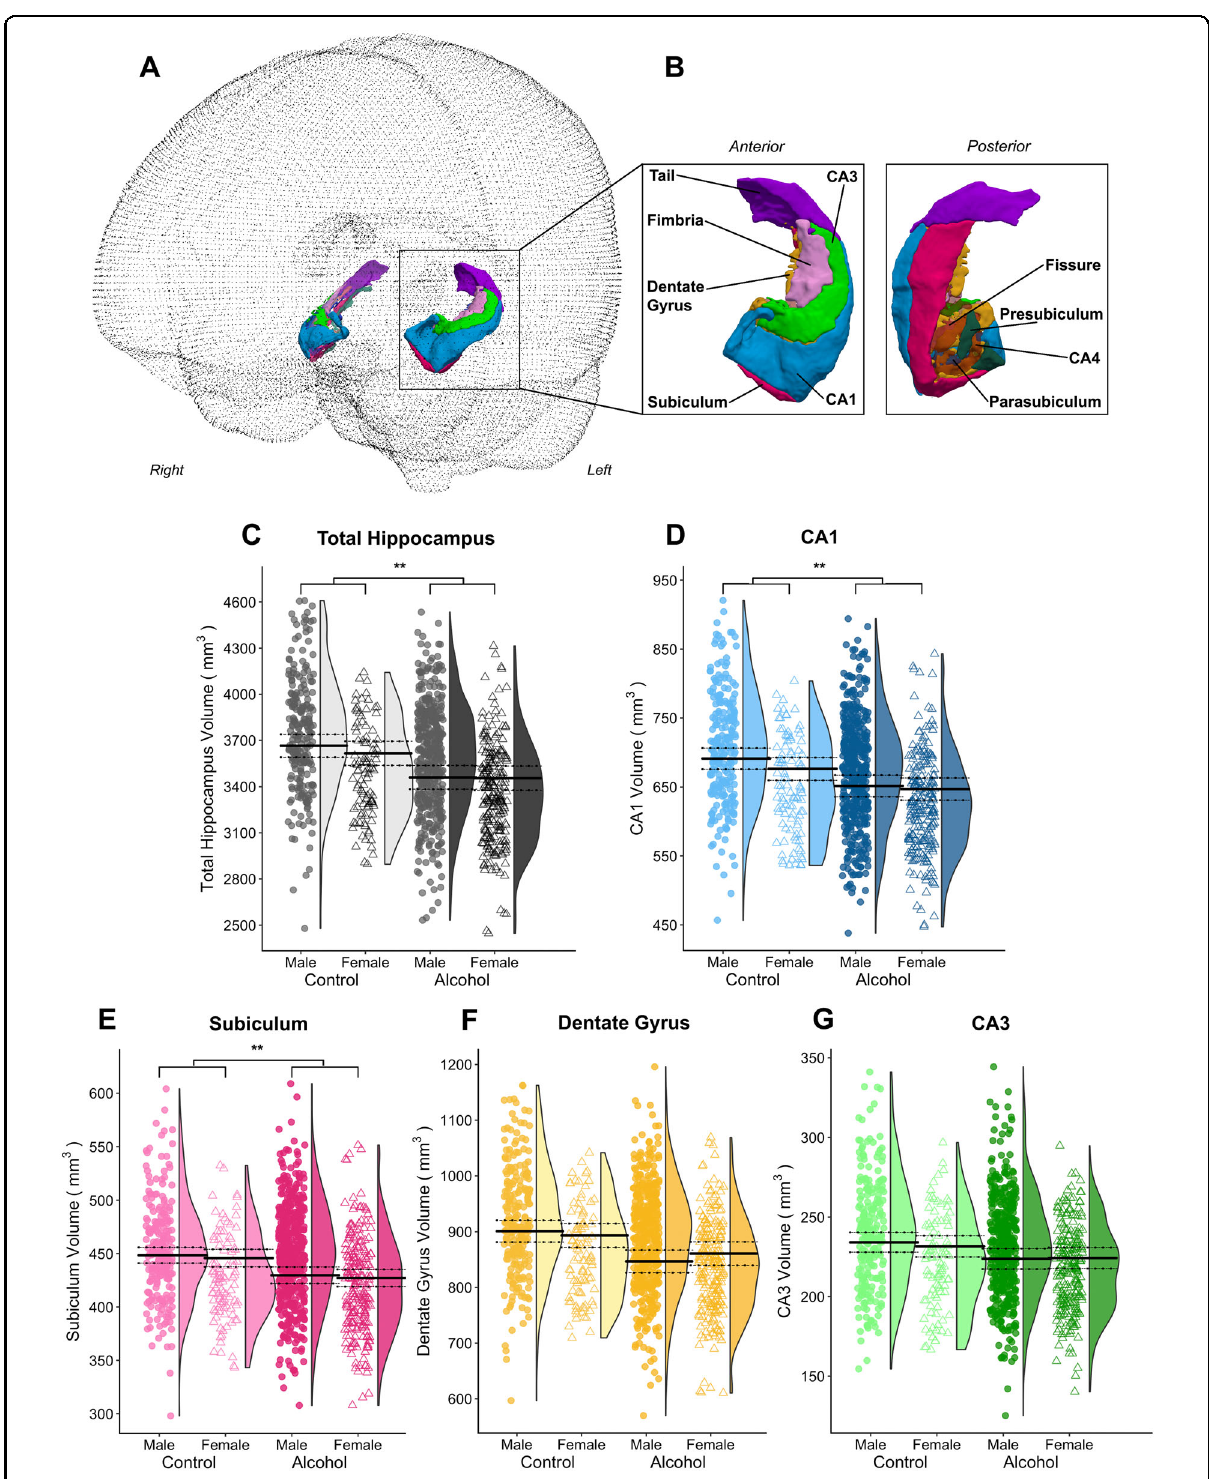
Fig. 3 Overview of group by sex effects on the volume of a-priori hippocampual region and hippocampus sub fi elds. A Overview of glass brain section showing 3D rendering and B close up of 3D renders of all hippocampal sub fi elds from an example participant. Plots of the a priori C total hippocampus and D cornu ammonis 1 (CA1), E subiculum, F dentate gyrus, and G cornu ammonis 3 (CA3) sub fi elds; containing individual data points and the probability density of the data strati fi ed by group and sex (the group average of the estimated marginal means predicted by the models are indicated by the solid black line, with dotted lines indicating the standard error of the marginal means). The left and right hemispheres for the sub fi elds have been collapsed. ** p (FDR) <